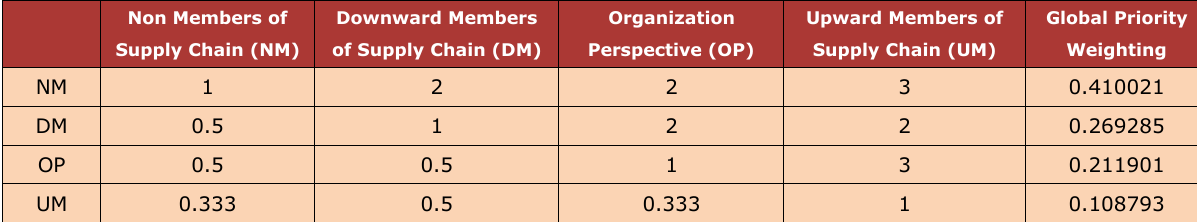
Table 2. Strategies of four dimensions to implement GSCM